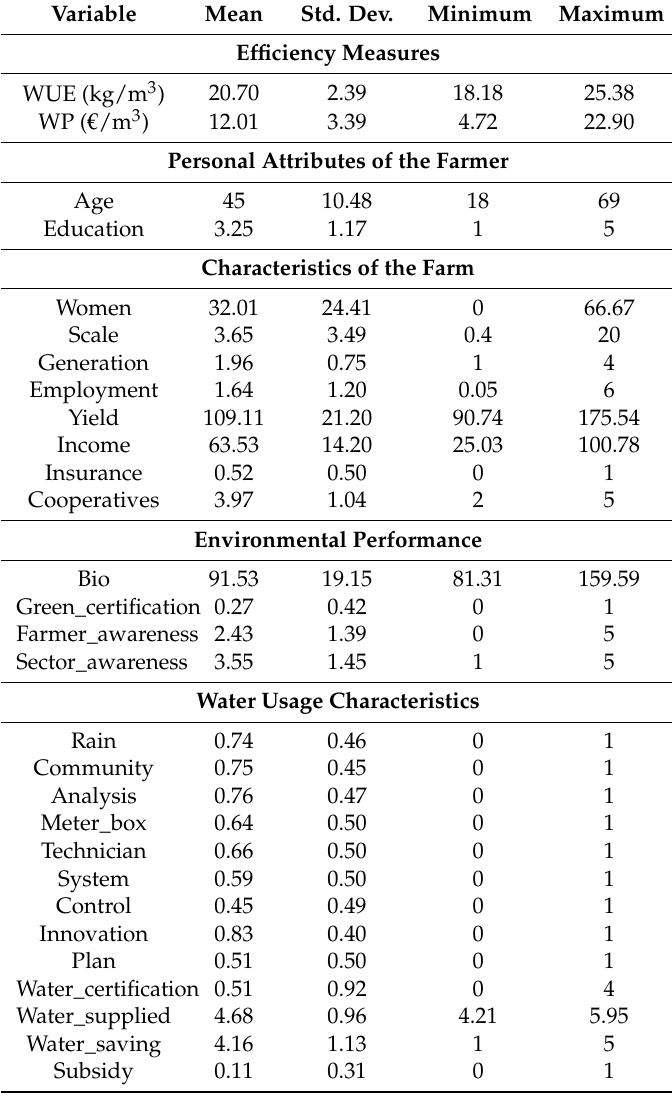
Table 2. Summary statistics for the main variables of the